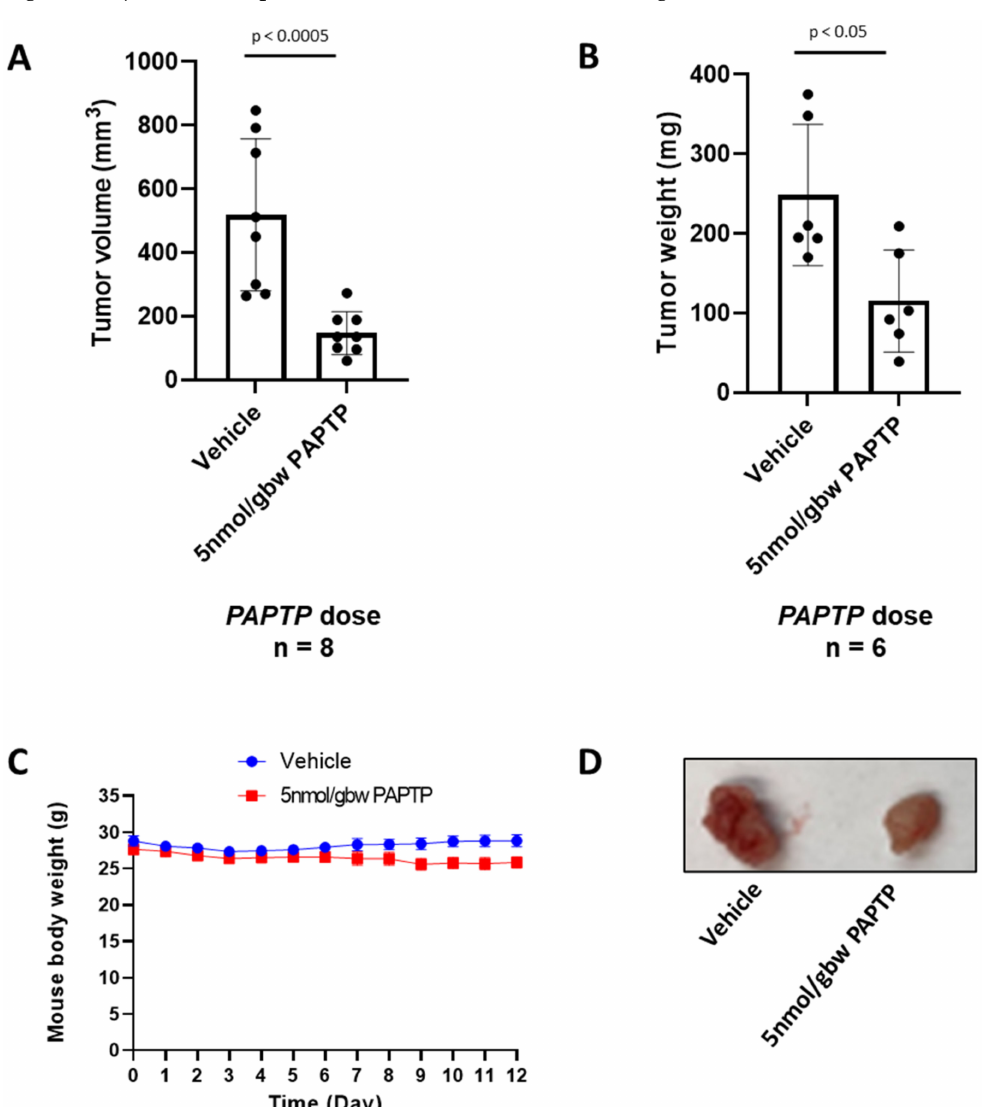
Figure 4. PAPTP reduced pancreatic tumor size in an orthotopic mouse model. ( A , B ) PAPTP reduced mouse pancreatic tumor volume ( A ) and weight ( B ) orthotopically significantly by intraperitoneal administration, n = 6. ( C ) Body weights change of the mice during PAPTP treatment were not signifi- cantly changed ( p = 0.17). ( D ) Representative pictures of the mouse orthotopically injected